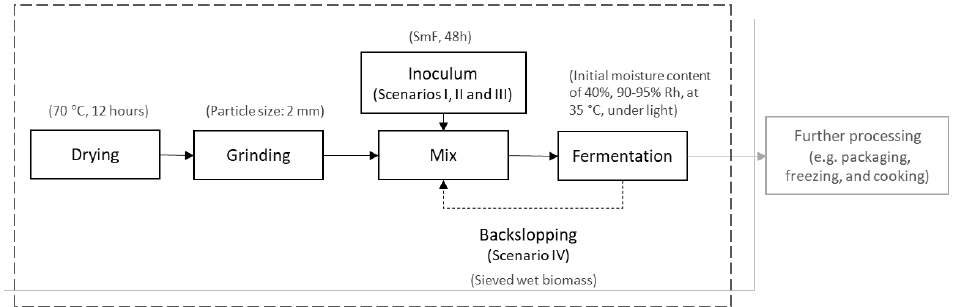
Figure 1. Basic process flow chart. The conditions of each process are described in brackets. The dotted box represents the system boundaries of the study. The further processing of the fungal biomass after fermentation is not included in the system boundaries.